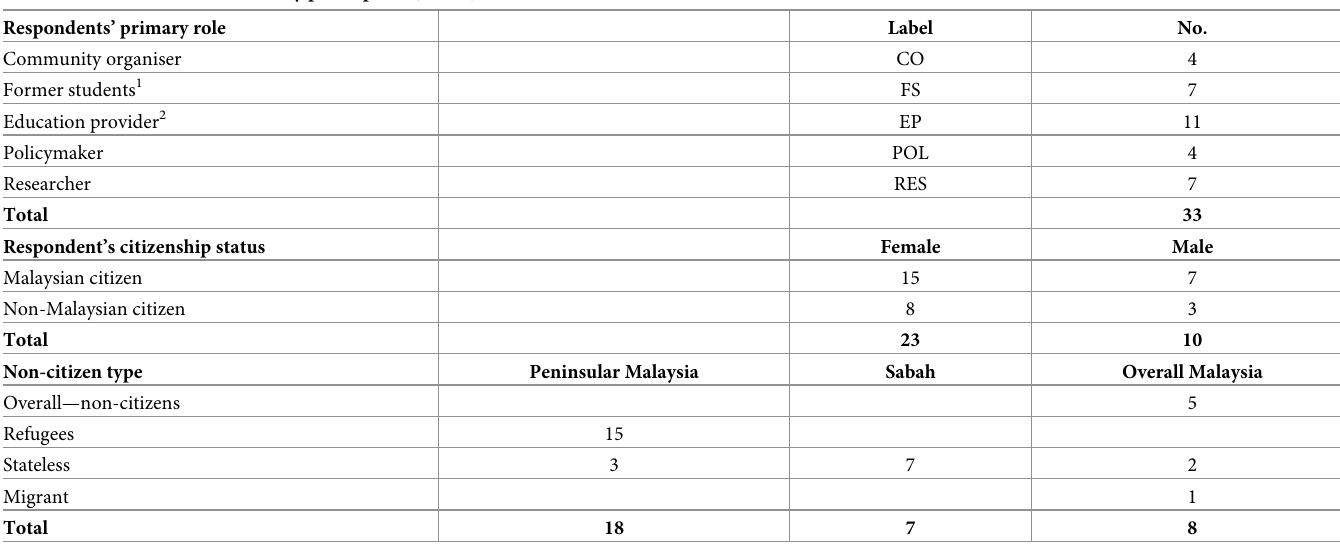
Table 1. Characteristics of the study participants (n =